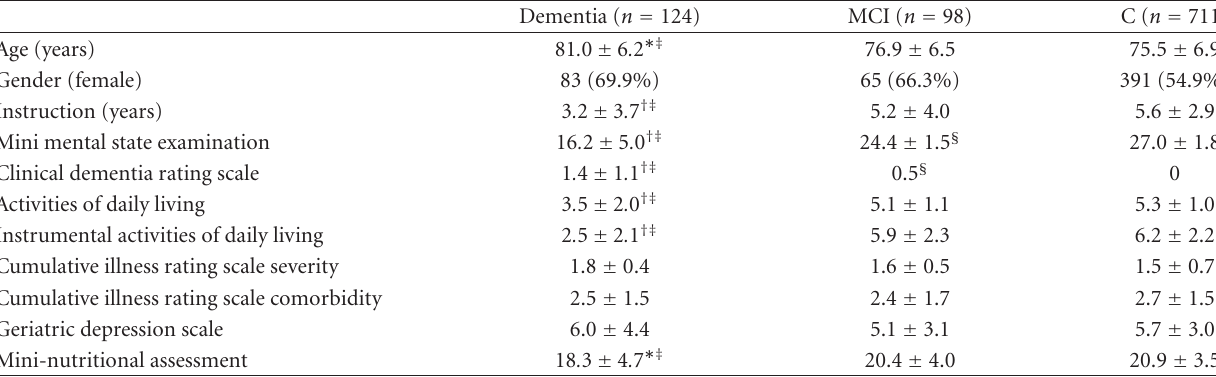
Table 1: Demographic and clinical characteristics of patients according to the cognitive levels.